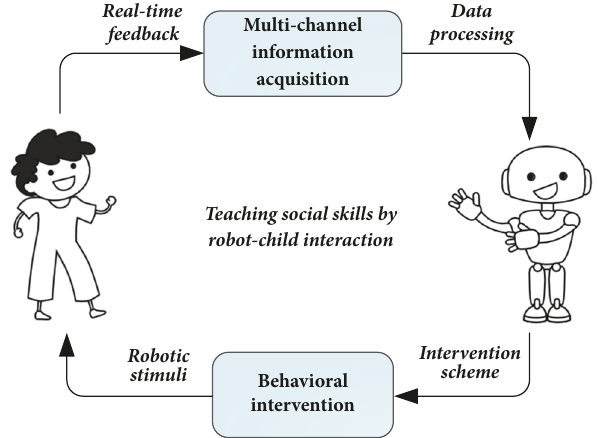
Figure 1: A basic overview of the robot application for autism